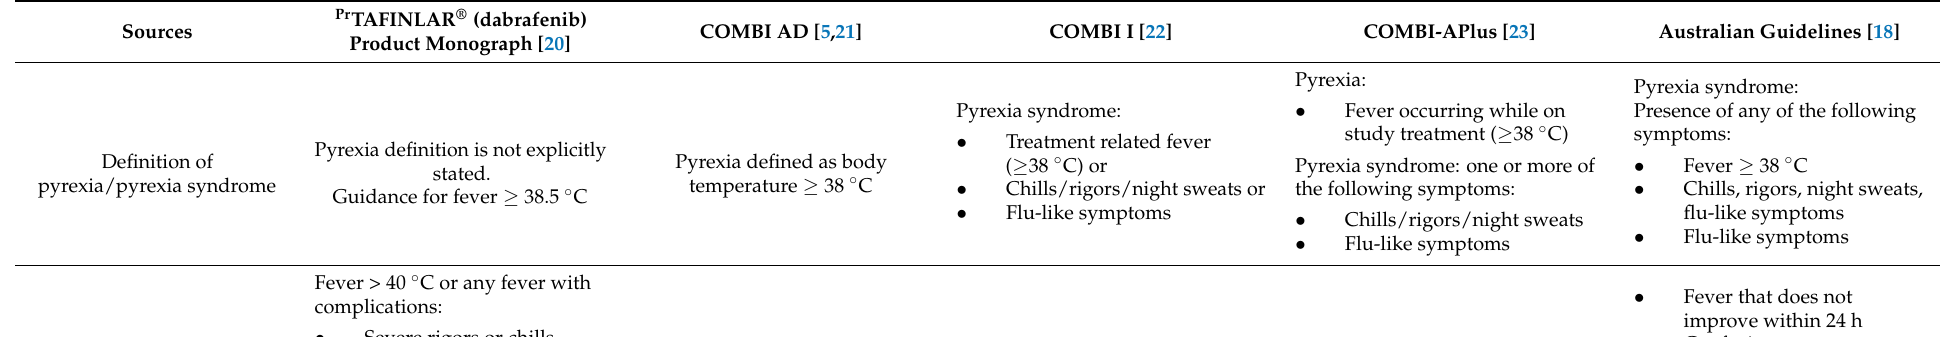
Table 1. Different definition and recommendations for the management of pyrexia